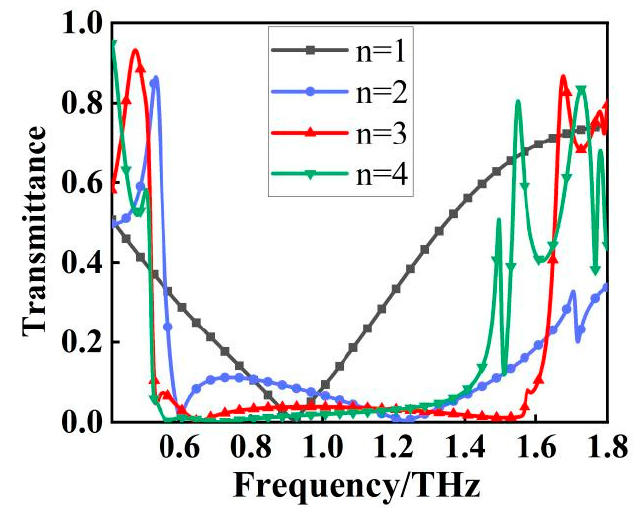
Figure 5. Transmittance curves corresponding to different structures.